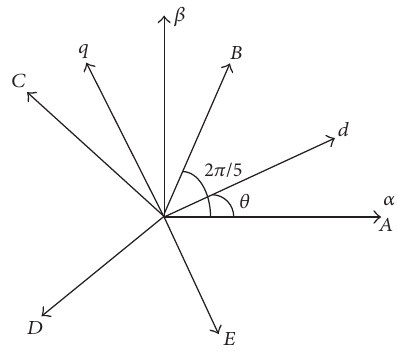
Figure 3: Five-phase fundamental coordinates of the FT-FSPM